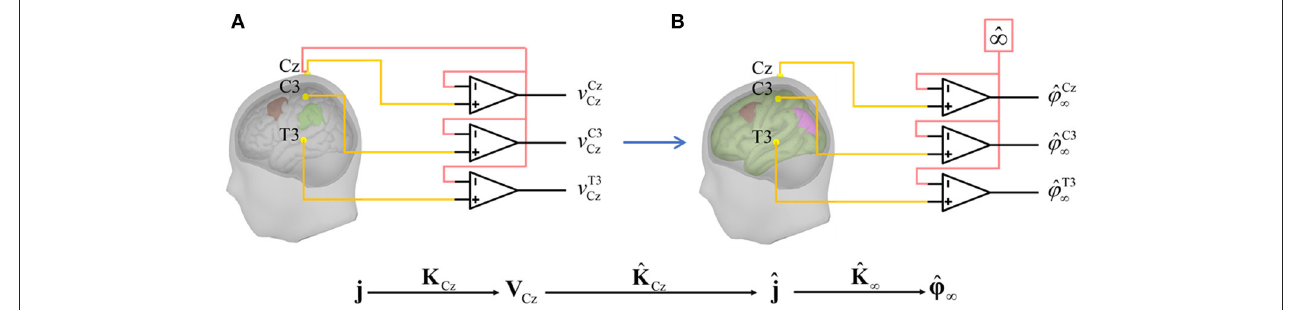
FIGURE 2 | Diagram of REST. (A) measured EEG potentials v Cz with reference to Cz; j and K Cz are the actual source activities and the actual lead field with reference to Cz, respectively; (B) for REST, one first builds the lead field ˆ K ∞ with estimated head model and equivalent sources, then transforms the lead field with reference to Cz as ˆ K Cz ; with this lead field, one enables to estimate the equivalent source activities ˆ j ; after, the equivalent source activities are taken the forward calculation through ˆ K ∞ to ˆ ϕ ∞ which is the approximation of EEG potentials at